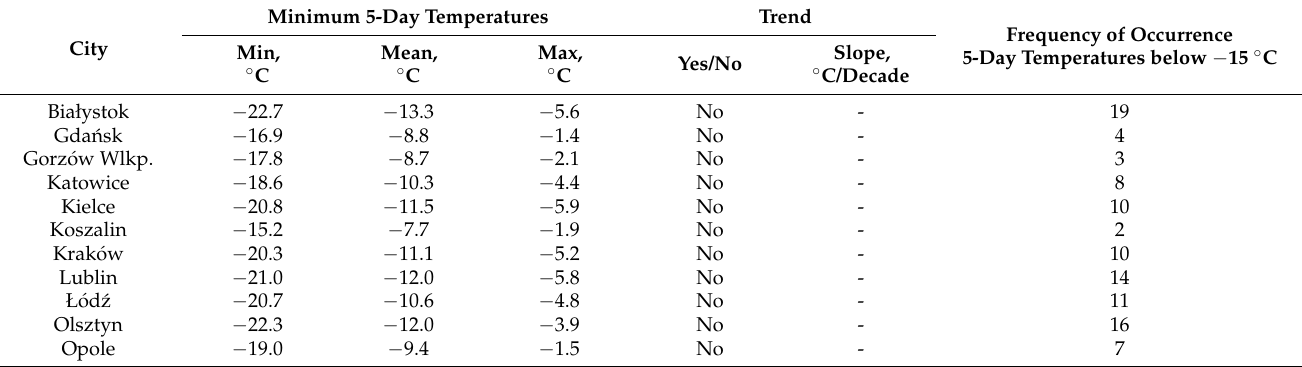
Table 2. Analysis of the minimum five-day temperatures between 1970 and